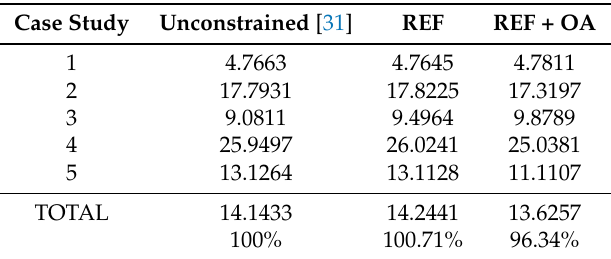
Table 4. Average distance between cluster centers and reference positions, in centimeters, for the unconstrained system [31], the system with reprojection error filtering (REF), and the system with reprojection error filtering and orientation alignment (REF +